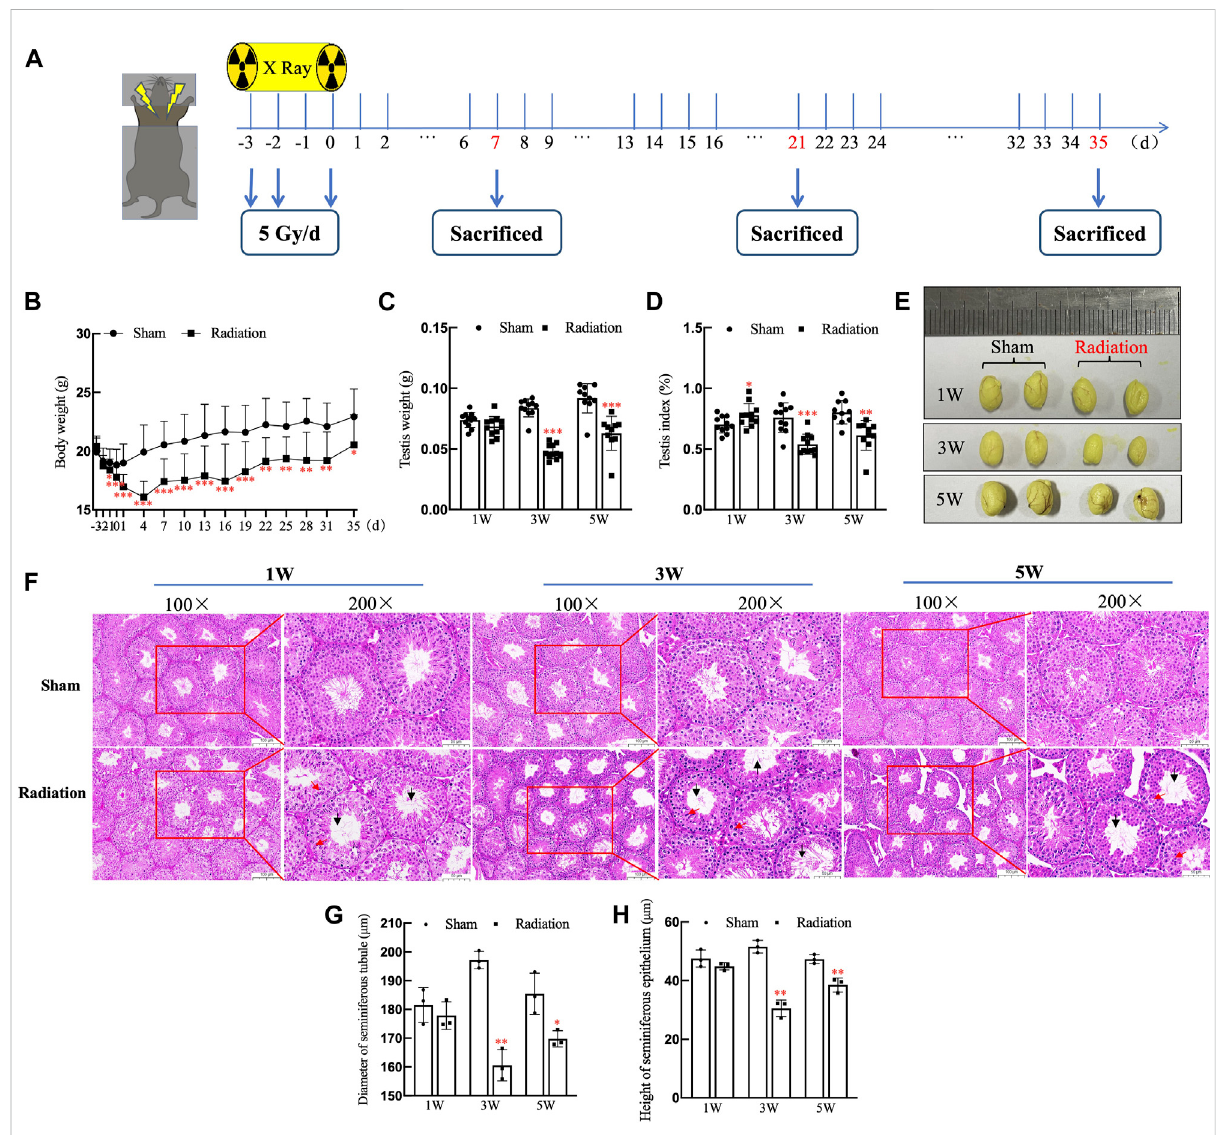
FIGURE 1 AbscopaleffectsofthoracicX-rayirradiationontesticularhistologyinmice. (A) Timescheduleofirradiationformice. (B) Bodyweightofmiceat differenttimepoints, n =10foreachgroup. (C) Testisweight, n =10foreachgroup. (D) Testisindex, n =10foreachgroup. (E) Testisvolume, n =3for eachgroup. (F) HEstainingoftestes, n =3foreachgroup,bar=100 μ m(×100);50 μ m(×200). (G – H) Diameterofseminiferoustubulesandheightof seminiferous epithelium calculated randomly from 50 round or nearly round cross-sections of the seminiferous tubules (long axis: short axis < 1.2:1) for each group. The values are expressed as the mean ± SD, * p < 0.01; ** p < 0.01; *** p < 0.001 vs. sham